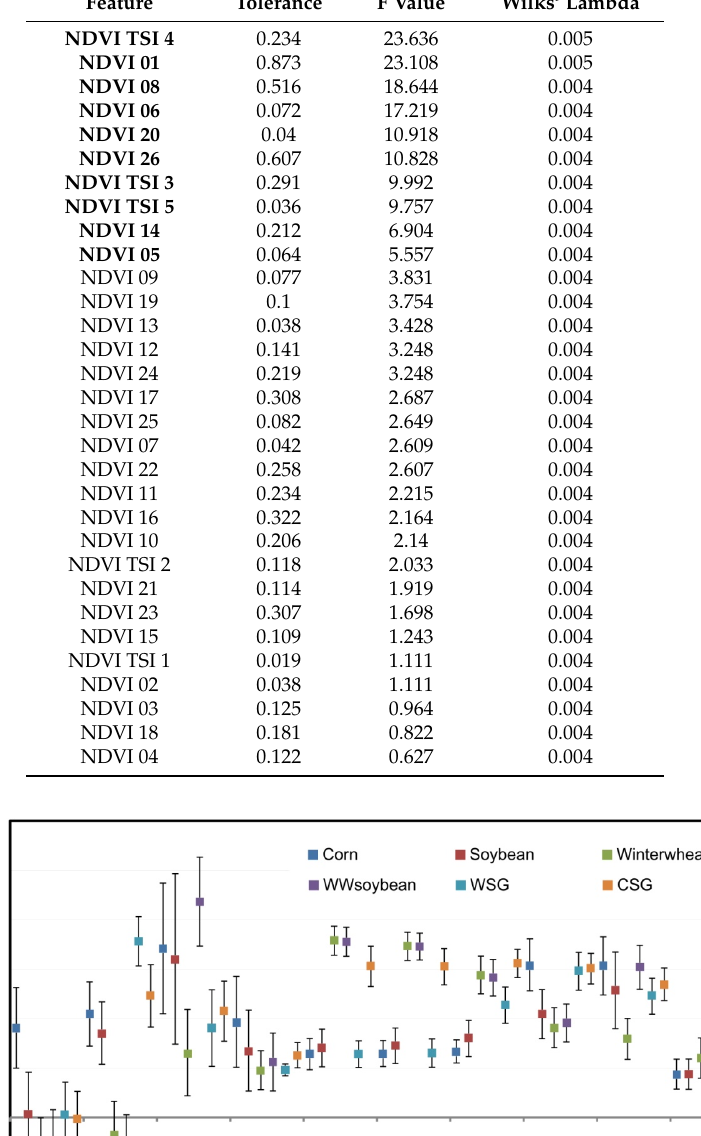
Table 3. F value of 31 features after 10 steps of SDA analysis.